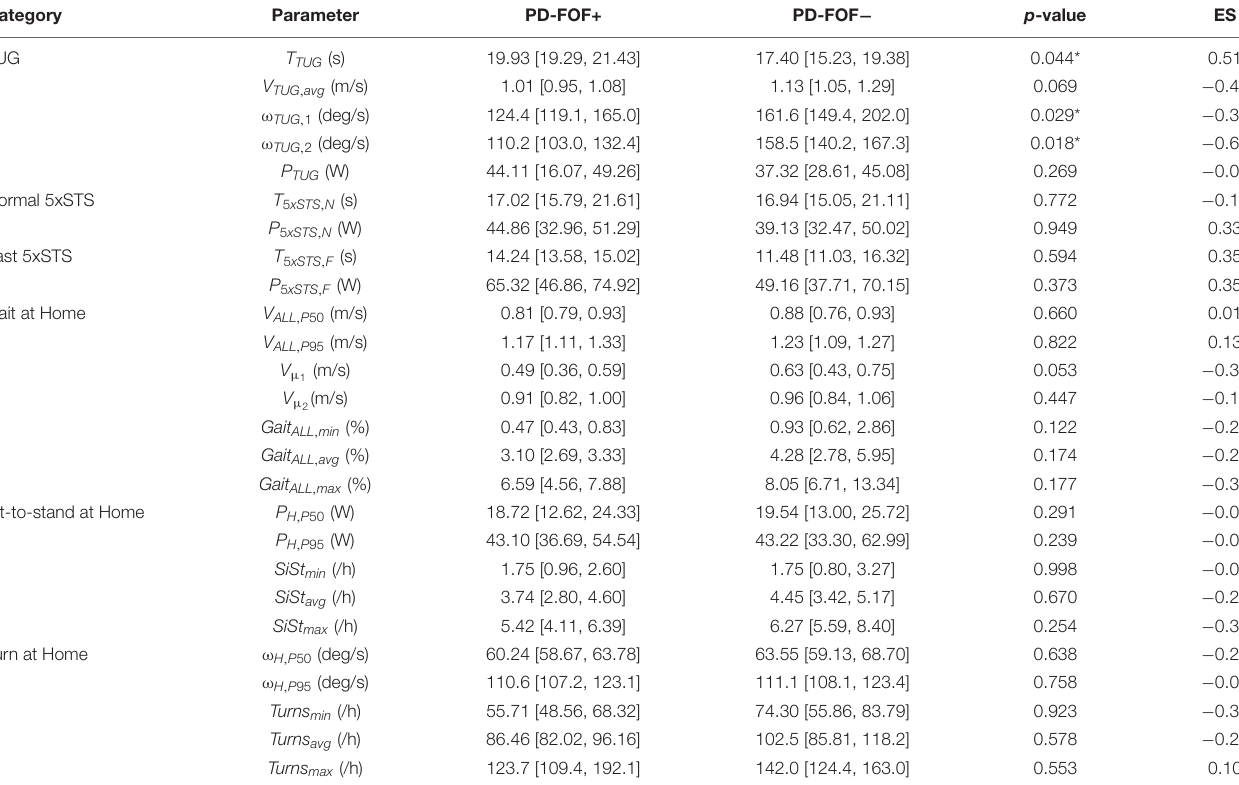
TABLE 2 | Comparison of the extracted parameter between the group with fear of falling (FOF) (PD-FOF+) and without (PD-FOF − ). Category